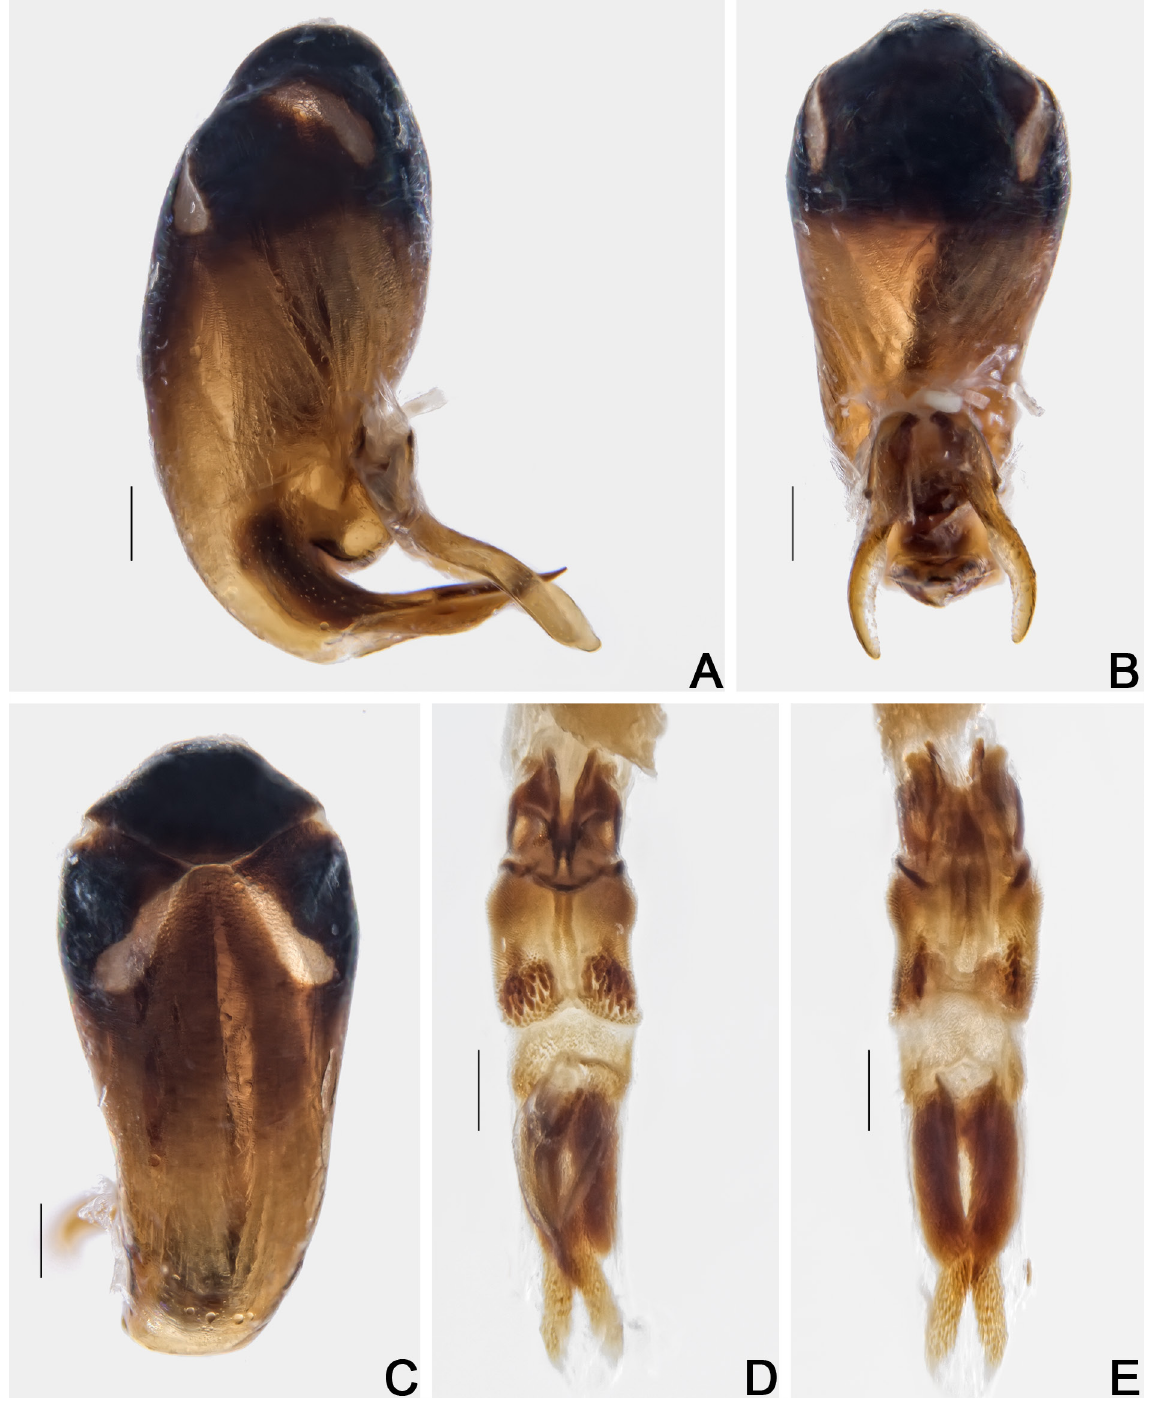
Fig. 44. Cyparium pici sp. nov., paratype, ♂ (CELC). A–C . Aedeagus. A . Lateral view. B . Frontal view. C . Dorsal view. D–E . Internal sac. D . Frontal view. E . Dorsal view. Specimen collected at Cotriguaçu (MT, Brazil). Scale bars = 0.2